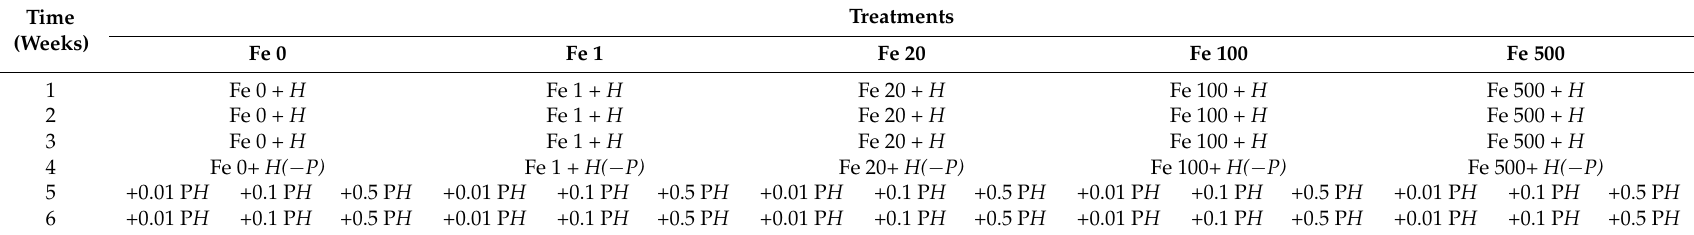
Table 1. Experimental treatment for a fully factorial design with three regimes and two main factors: Fe 2+ (0, 1, 20,100, 500 mg · L − 1 Fe) and P (0.01, 0.1, 0.5 mg · L − 1 P). Treatments Time (Weeks) Fe 0 Fe 1 Fe 20 Fe 100 Fe